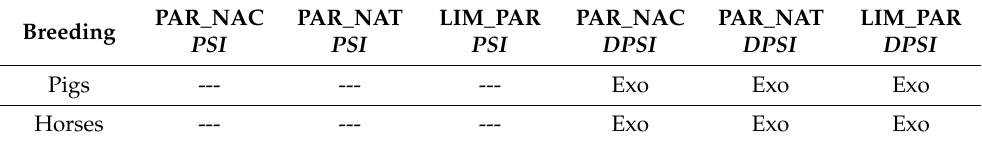
Table 4. Trends in specialization according to the types of livestock (1989–2009).